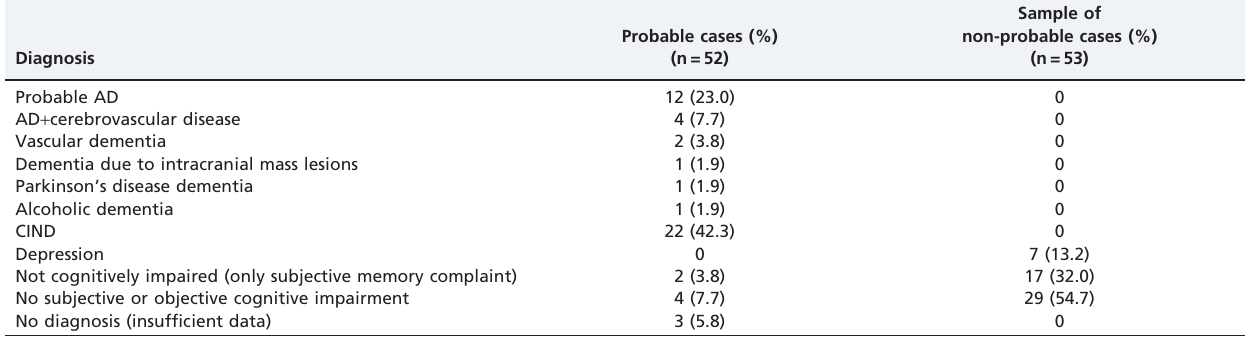
AD: Alzheimer’s disease; CIND: cognitive impairment with no